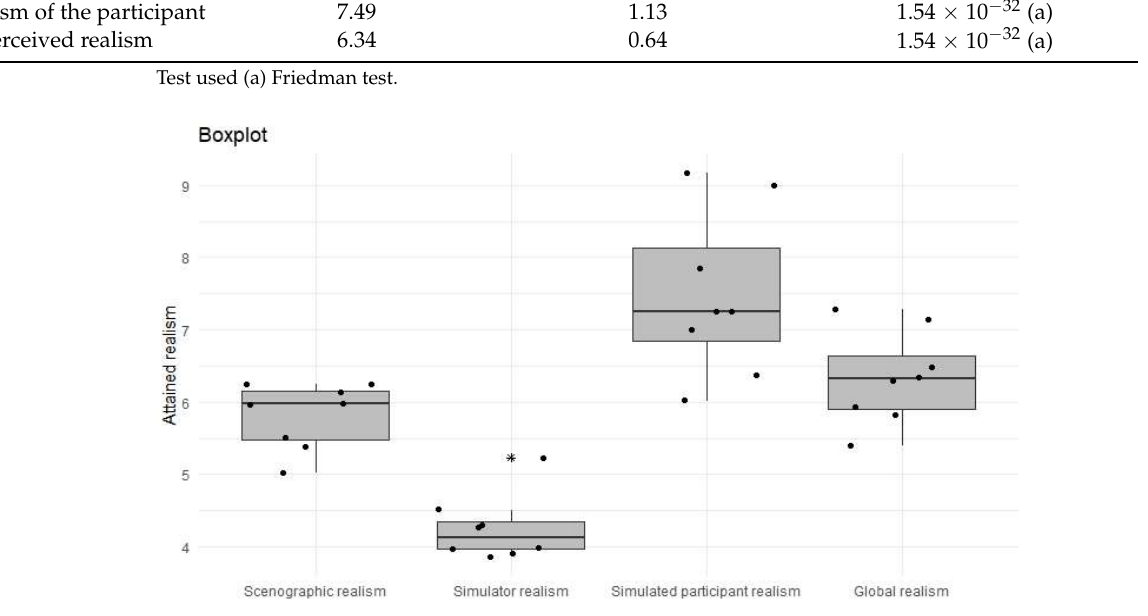
Figure 3. Box plot of realism as perceived by teachers. Figure 3 . Box plot of realism as perceived by teachers .